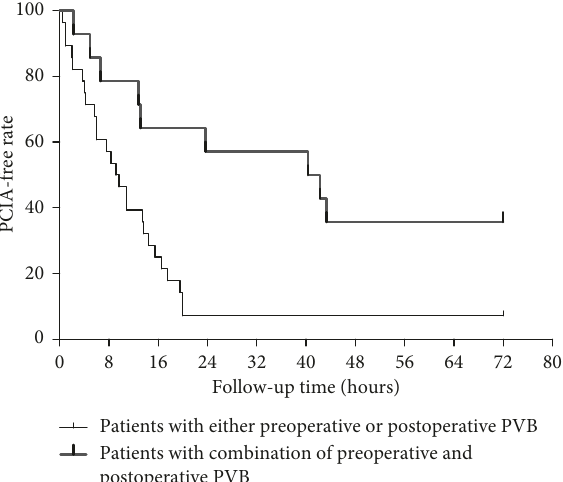
Figure 3: Kaplan–Meier survival analysis showed PCIA-free survival curve is different between patients with combination of preoperative and postoperative PVB (Group C) and patients with either preoperative or postoperative PVB (Group A +B), p � 0 .